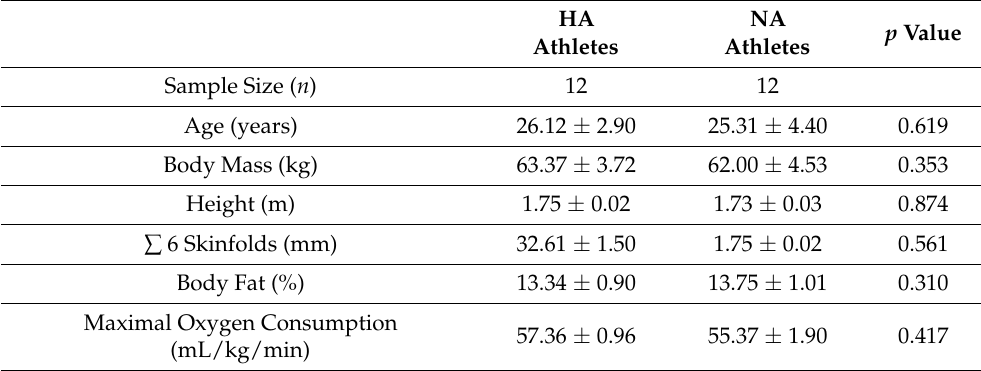
Table 4. The characteristics of the athletes at the baseline of the